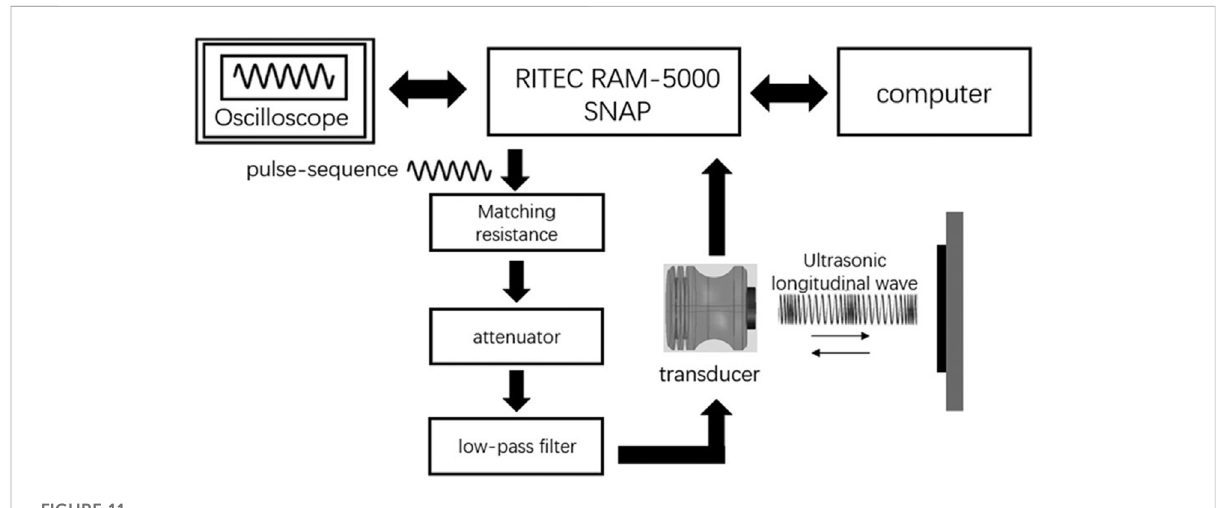
FIGURE 11 High-power ultrasonic testing system (Wang et